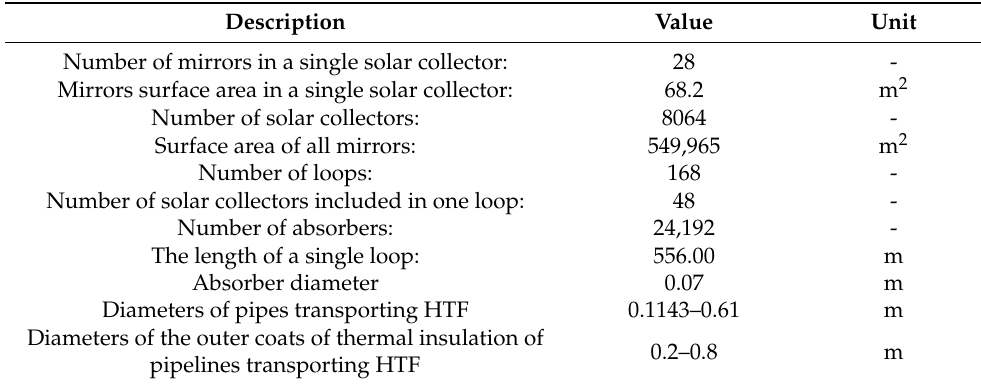
Table 1. Description of the elements of the collector field in the Solar Thermal Power Station of te south of Spain.